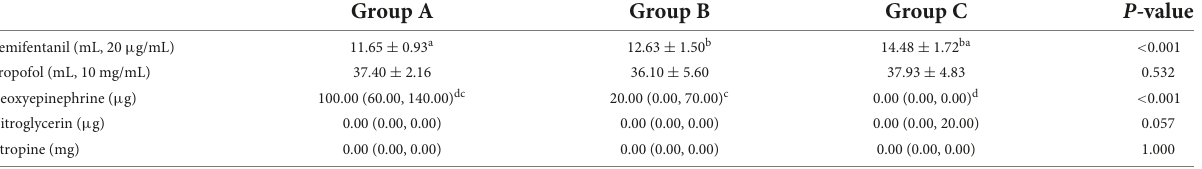
TABLE 4 Comparison of intraoperative medication among the three groups.